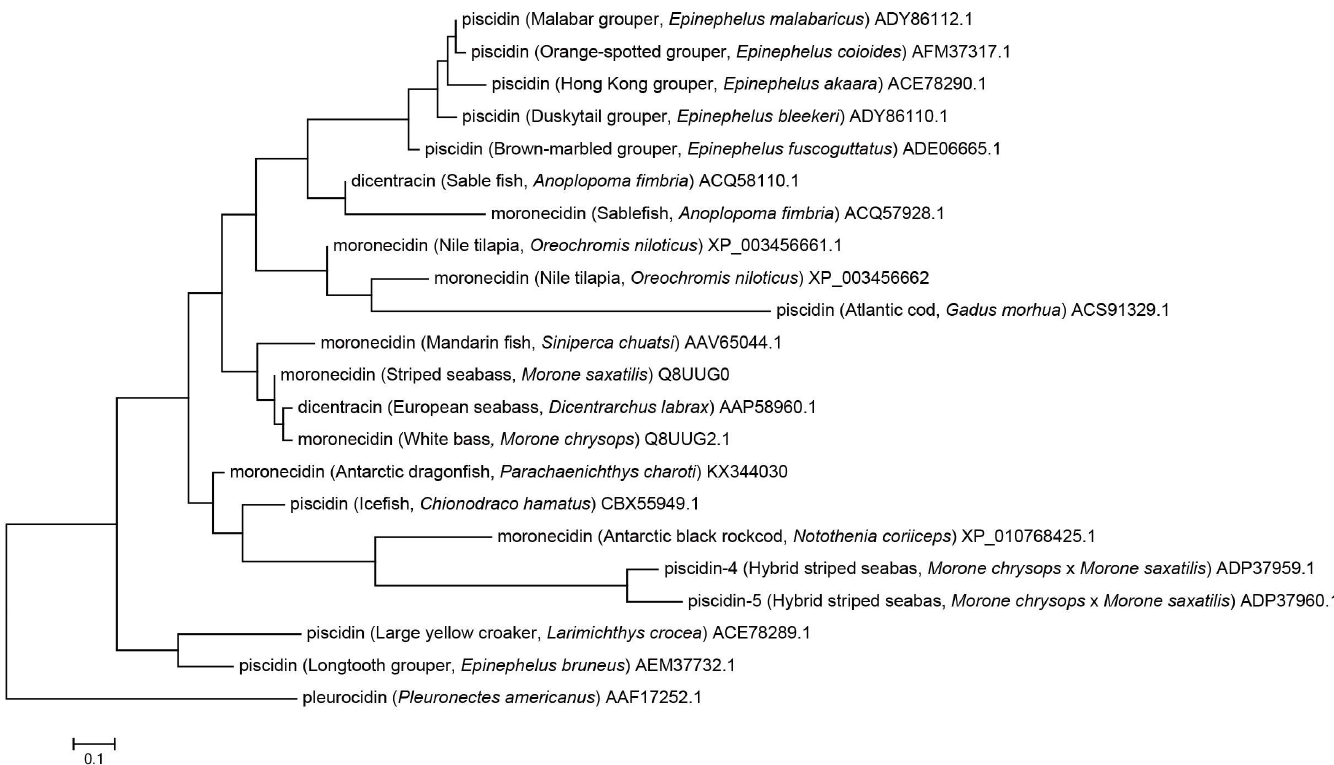
Fig 2. Phylogenetic tree showing the relationship between the two moronecidin-like peptides from Antarctic fishes and other known AMPs. The accession number of each AMP is the same as that given in Fig 1. The phylogenetic tree was constructed by the neighbor-joiningmethod using the bootstraptest with 2000 replicates. The scale bar denotesa 0.1 change per amino acid position.